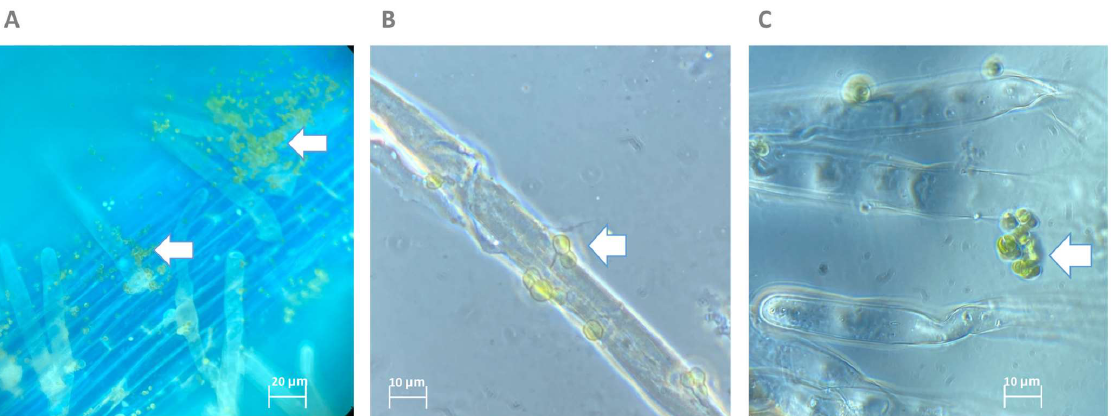
Figure 5. Microscopy observations of the tomato root colonization abilities of Micractinium rhizosphaerae NFX-FRZ. Arrows indicate the presence of the NFX-FRZ strain. ( A ) overview of the primary root tissue; ( B ) NFX-FRZ cells attached to plant root hairs; ( C ) clusters of NFX-FRZ cells bound to plant root hairs.